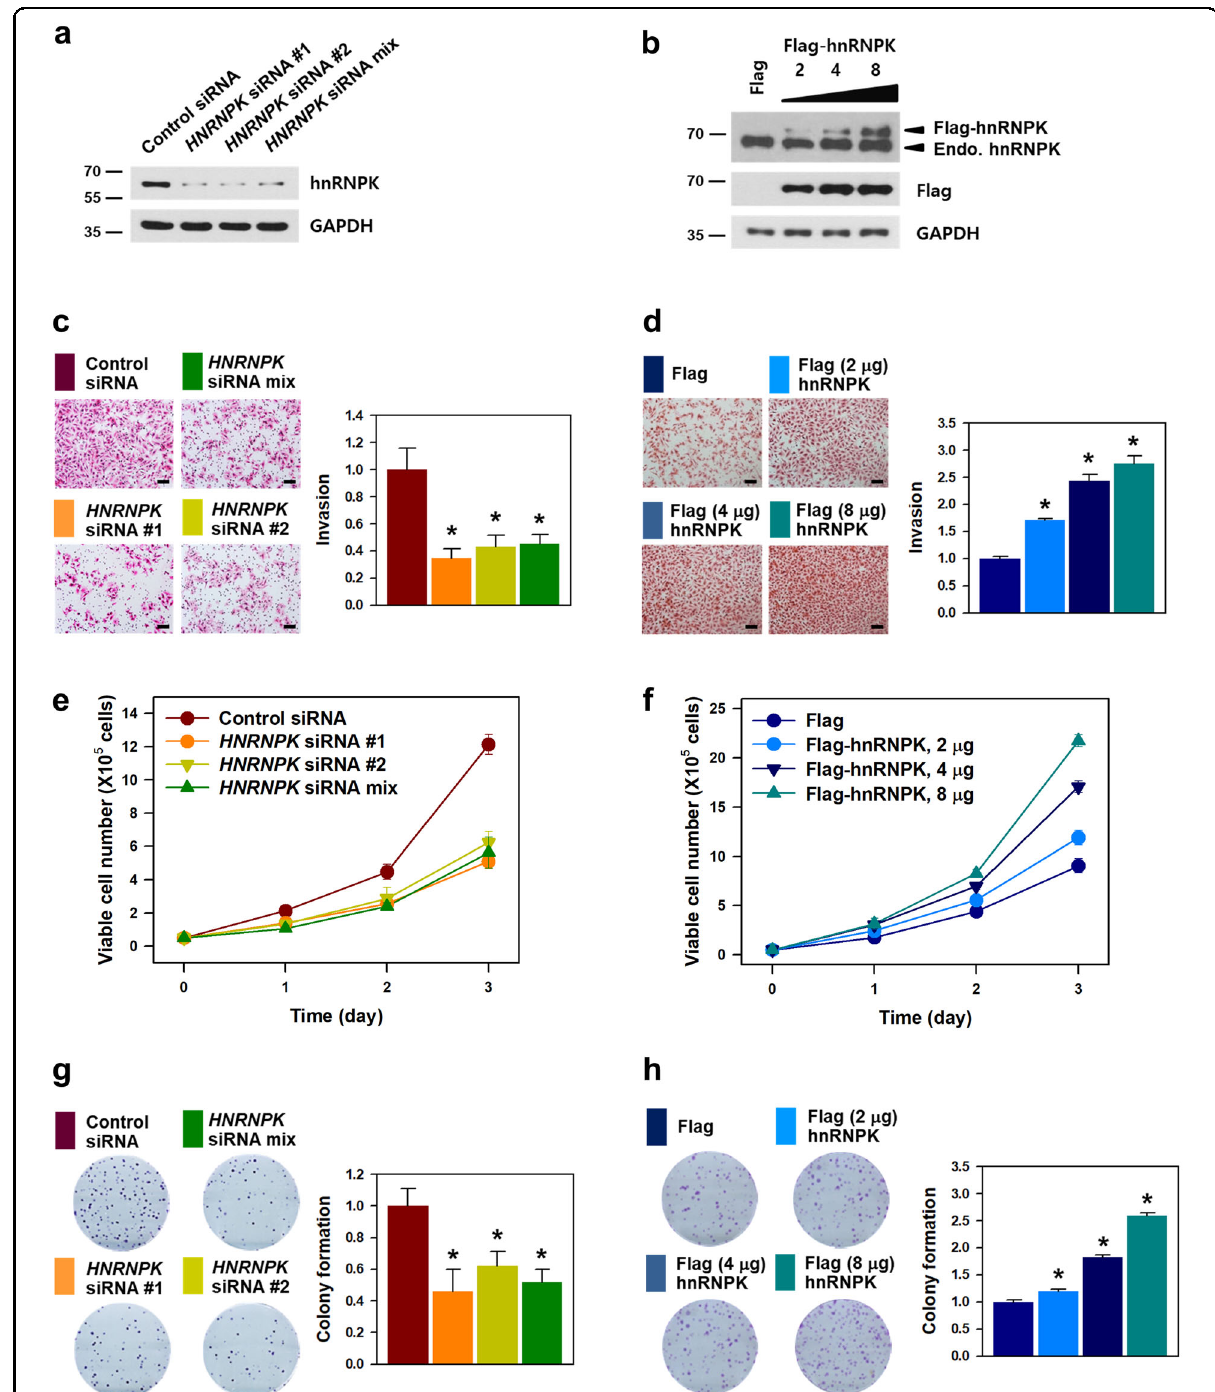
Fig. 1 hnRNPK is responsible for the cancer malignancy. To investigate the role of hnRNPK in malignant phenotype, two individual and mixed HNRNPK siRNAs were transfected into HeLa cells ( a , c , e , and g ). In contrast, the Flag-hnRNPK vector was constructed and used for hnRNPK overexpression ( b , d , f , and h ). a , b The ef fi ciency of hnRNPK knockdown ( a ) and overexpression ( b ) was determined by analyzing the level of hnRNPK by Western blot analysis. c , d Invasive ability was assessed by Transwell invasion assay in vitro. Representative images of the invaded cells are shown. Invasiveness was determined by counting the number of invaded cells from more than ten fi elds. e , f To determine the proliferation rate, an equal number of transfected HeLa cells were plated in 12-well plates and the number of viable cells was counted under a microscope at the indicated times. g , h Equal number of transfected cells were plated in six-well plates, and clonogenicity was determined by counting the number of colonies. Bars on microscopic images represent 100 μ m. Statistical analyses were performed using the Student ’ s t -test using three independent experiments (* p <0.05). All data represent mean±standard variation